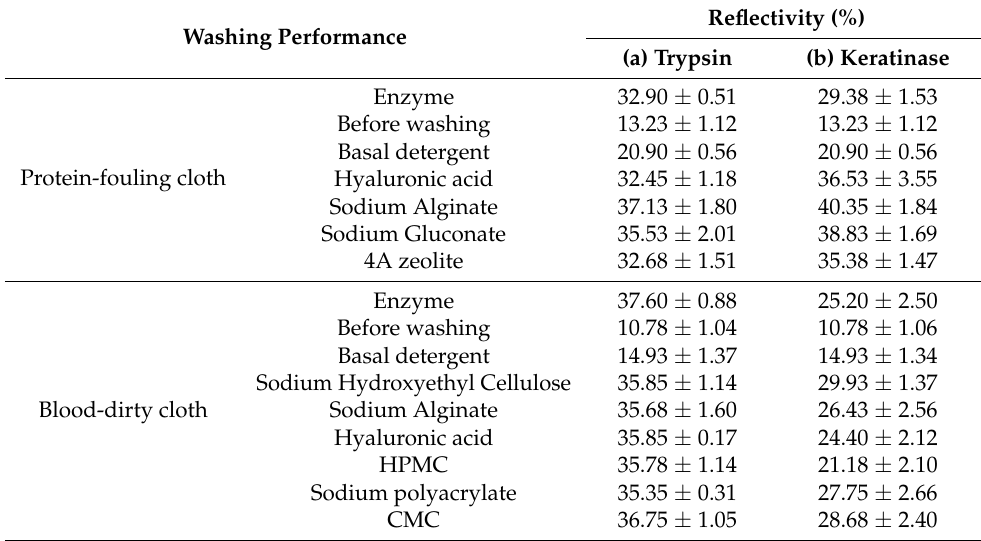
Table 4. Washing effect of detergent auxiliaries mixed with trypsin or keratinase on dirty cloths. Washing Performance